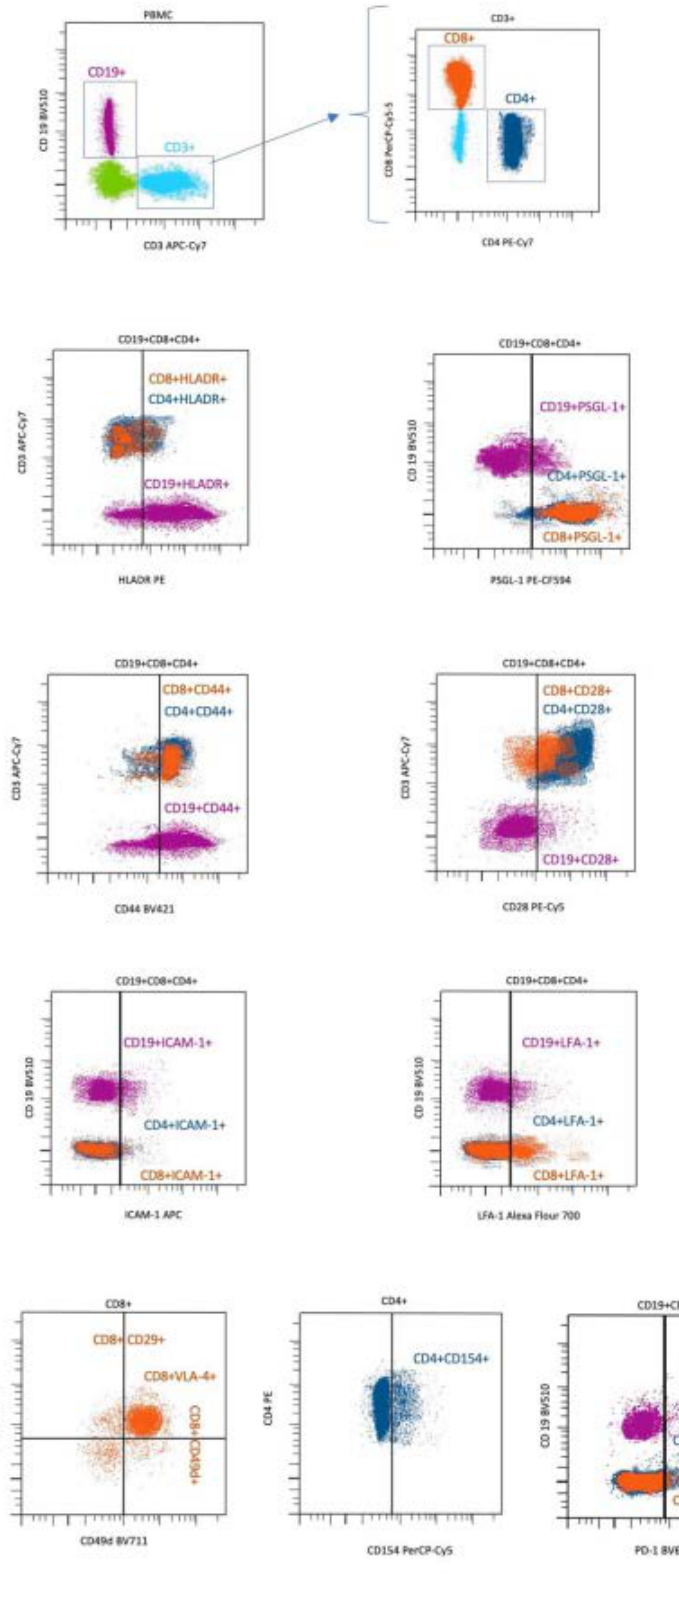
Figure A2. Gating